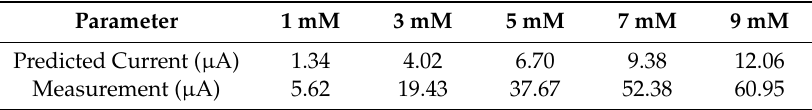
Table 3. Comparison of predicted and measured currents in dual mode at spin speed of 400 RPM at various